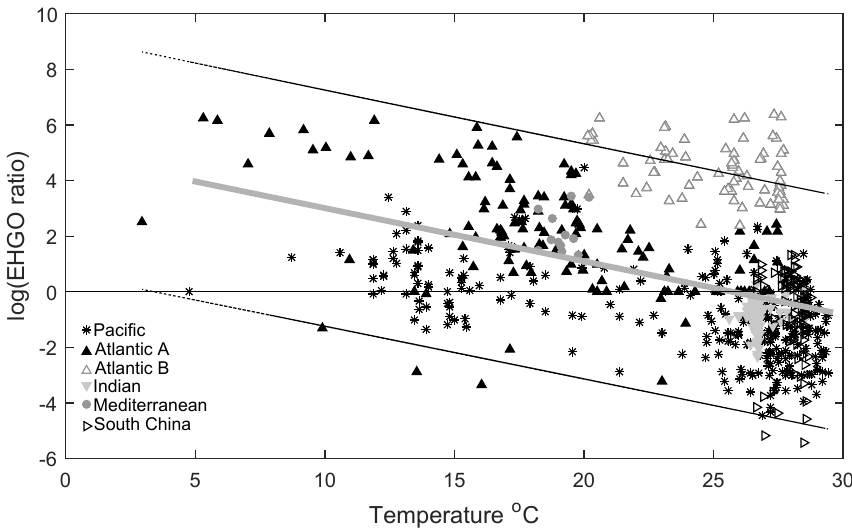
Figure 6. Log ratio of E. huxleyi to G. oceanica coccoliths versus temperature in the global oceans. Symbols and colours represent different ocean basins with data taken from McIntyre and Bé (1967), Chen and Shieh (1982), Roth and Coulbourn (1982), Knappertsbusch (1993), Andruleit and Rogalla (2002), Boeckel et al. (2006), Fernando et al. (2007) and Saavedra-Pellitero et al. (2014). Symbols denote samples from different oceanic regions with Atlantic B specifically representing samples from Boeckel et al. (2006) which appear influenced by upwelling of nutrients (see Sect. 4.4.2), while Atlantic A refers to samples from the Atlantic ocean from all other studies. The line at zero indicates a shift in dominance from E. huxleyi (>0) to G. oceanica (<0). The grey line represents a linear regression through the entire dataset with p <0.05 and F of 156.05 with 95% prediction bounds for new observations. For details, see Sect.